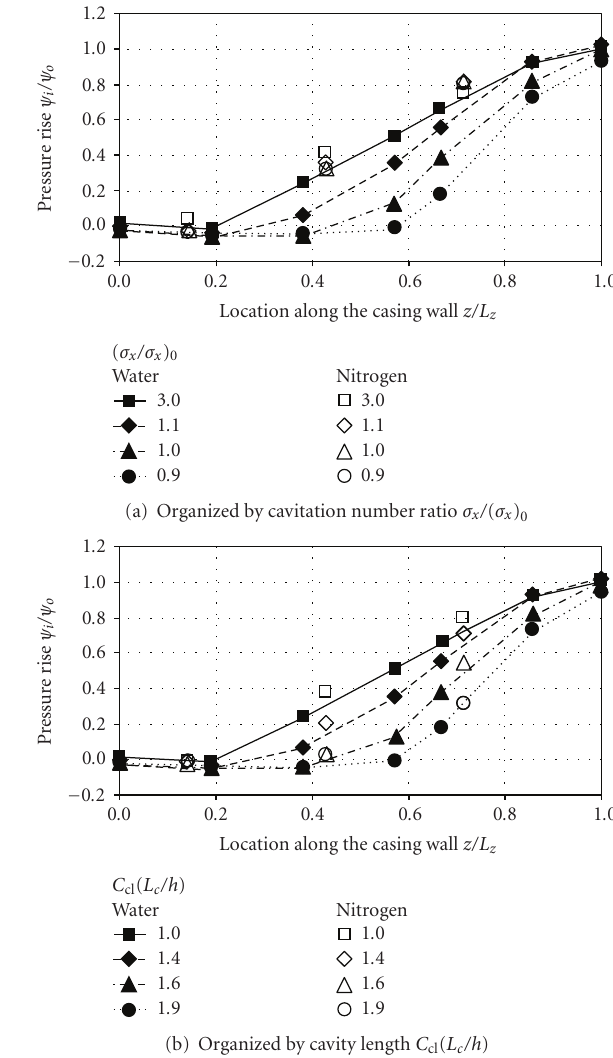
Figure 10: Pressure rise along the tip organized by cavitation number and cavity